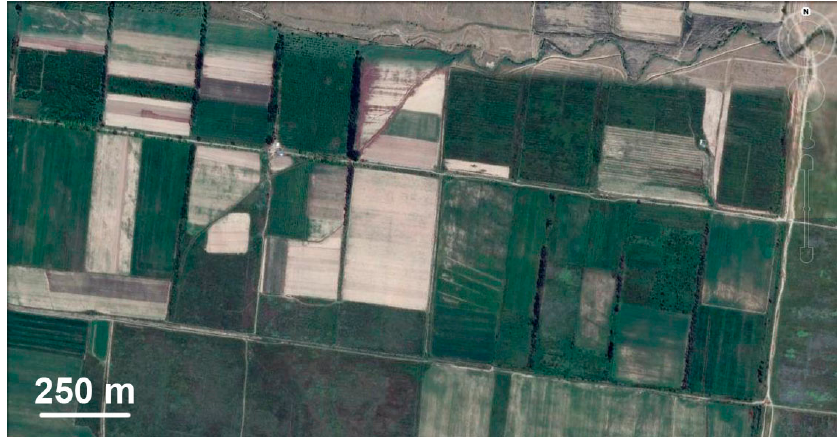
Figure 1. Field structure of Karasay Batyr as of 2016 (Google Earth).